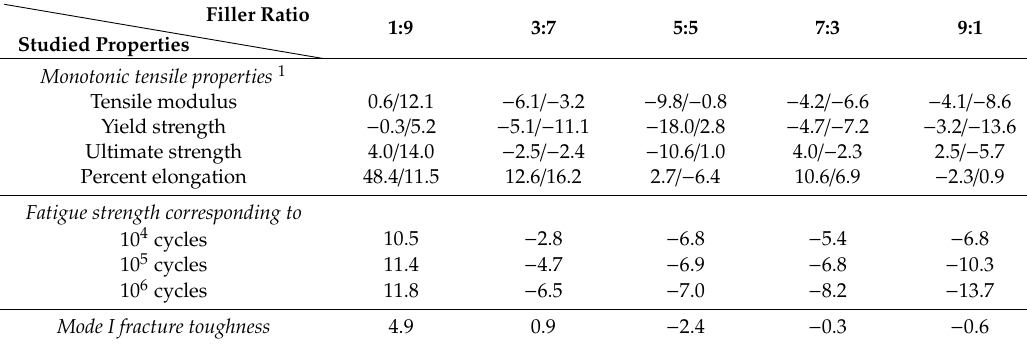
Table 2. Synergistic indexes for the studied mechanical properties. (%).